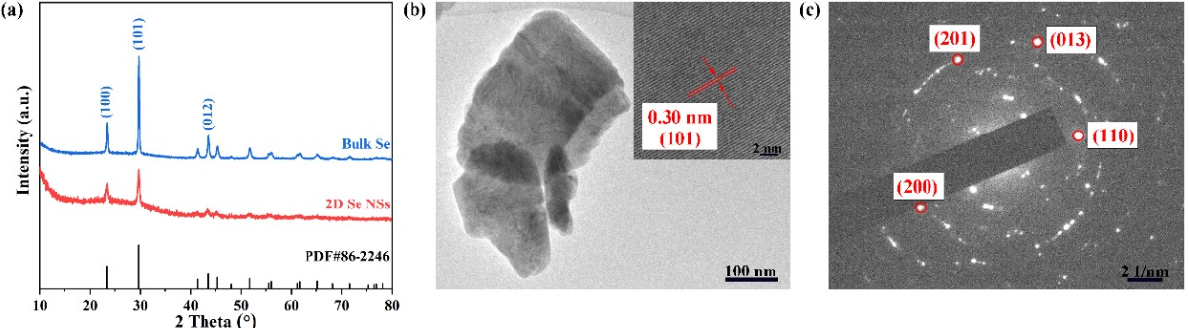
Figure 1. The structural characterization of the as-fabricated 2D Se NSs. ( a ) XRD patterns of bulk Se